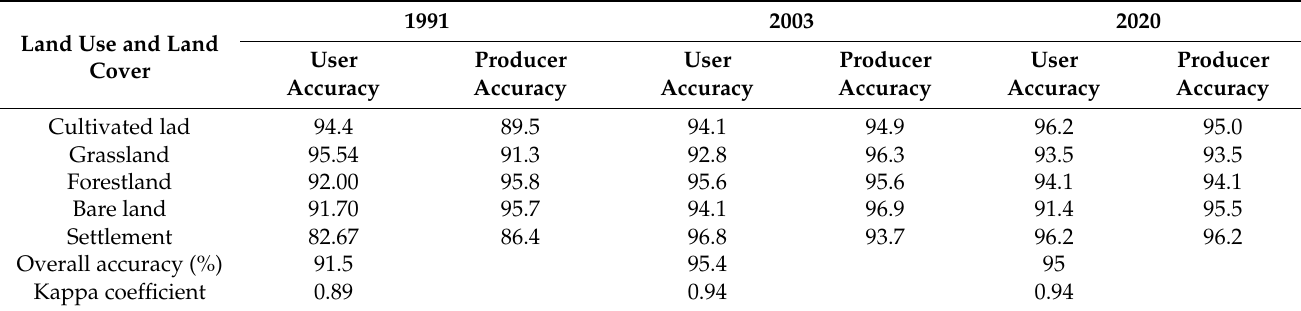
Table 3. Accuracy assessment for 1991, 2003, and 2020 classified images.